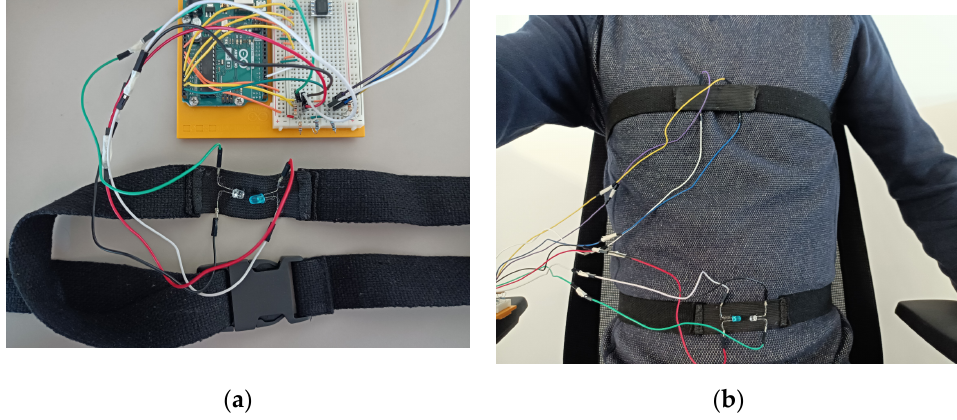
Figure 2. ( a ) Breathing belt with the phototransistor on the left of the stretchable strip and the LED on the right; ( b ) a target wearing two breathing belts, one on the chest, one on the belly. Equipment: 2 LEDs, 2 phototransistors, 2 elastic strips, 2 fabric belts with plastic buckles.